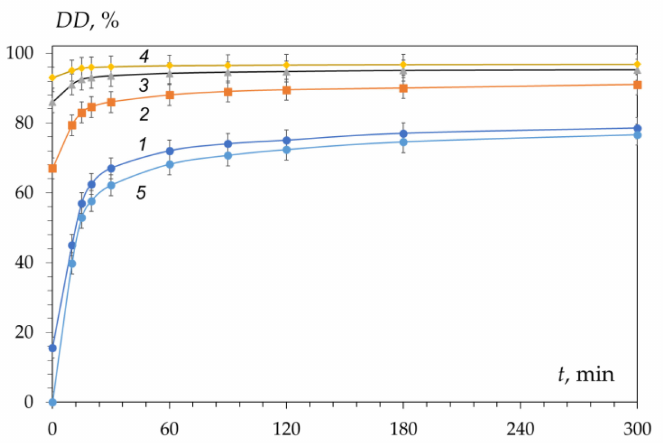
Figure 4. Kinetic curves for the deacetylation of chitin/chitosan with different DD 0 : 15.6% (1), 67% (2), 86% (3), 93% (4), and the “standard” curve (5). Reaction conditions: 50% NaOH; 95 ± 2 ◦ C. Original